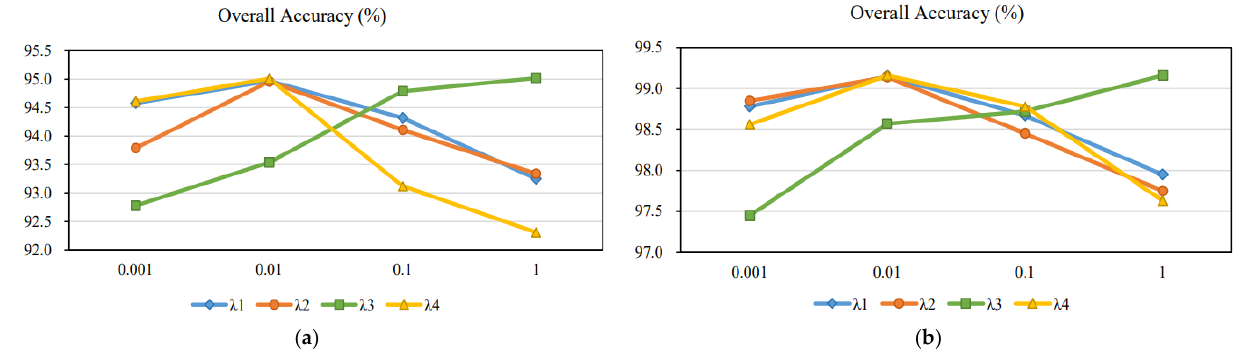
Figure 12. Effect of weight parameters on the classification performance of MA-PSNet. ( a ) Houston dataset. ( b ) Trento dataset.